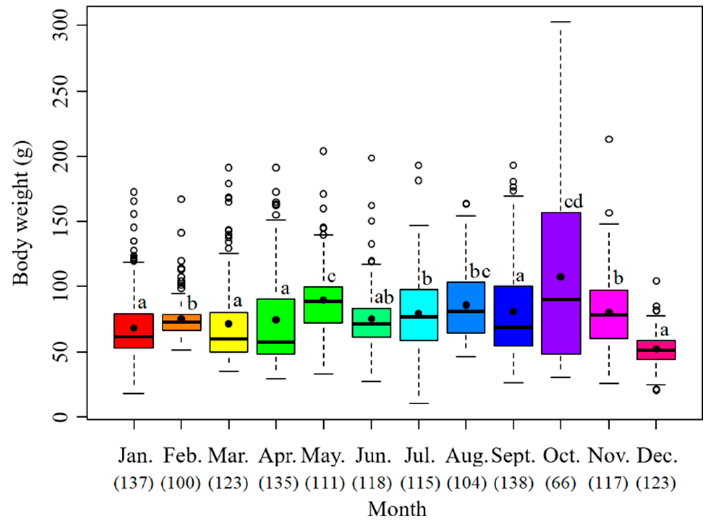
Figure 5. Monthly variation of body weights of S. oualaniensis . The black points are the mean values; the white points are the outliers; the thick horizontal lines are the medians; the thin horizontal lines are the upper and lower limits; the rectangles contain the middle 50% of the value. The data below the month represent the samples in number. Different letters means significant differences.